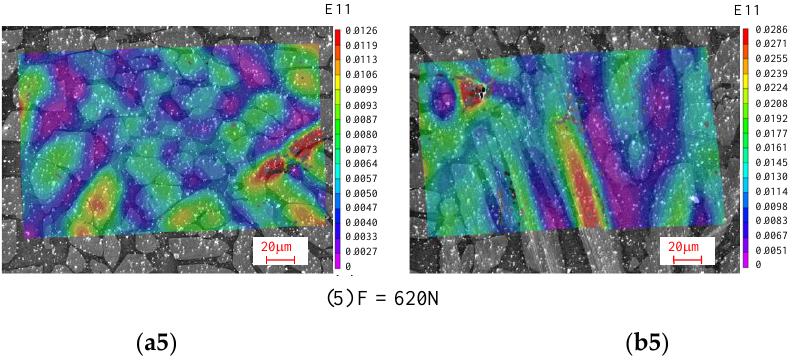
Figure 6. Schematic diagram of strain distribution in regions under different loads: ( a1 – a5 ) 1# and ( b1 – b5 ) 2# regions.